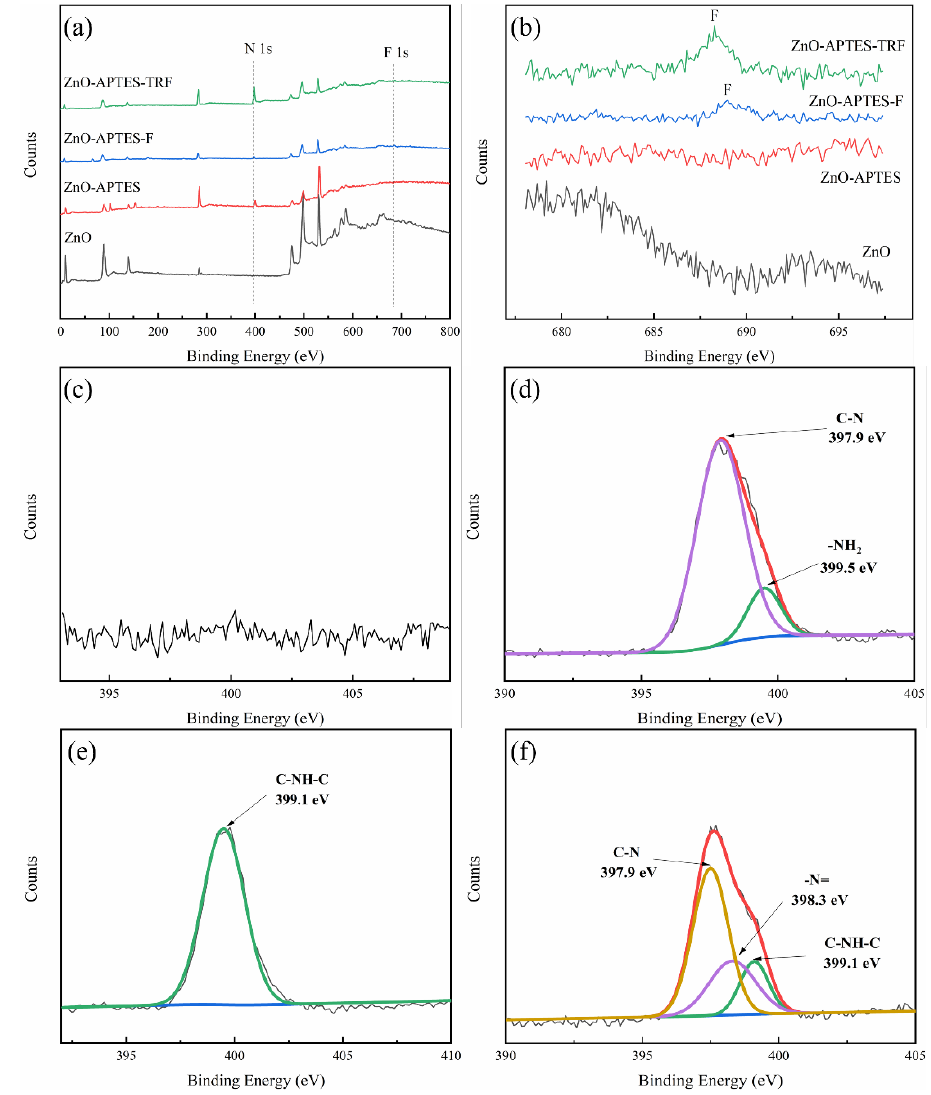
Figure 3. XPS spectrum analysis. ( a ) XPS spectrum; ( b ) XPS F1s peak diagram; ( c ) XPS N1s peak diagram of ZnO; ( d ) XPS N1s peak diagram of ZnO − APTES; ( e ) XPS N1s peak diagram of ZnO − APTES − F; ( f ) XPS N1s peak diagram of ZnO − APTES − TRF.